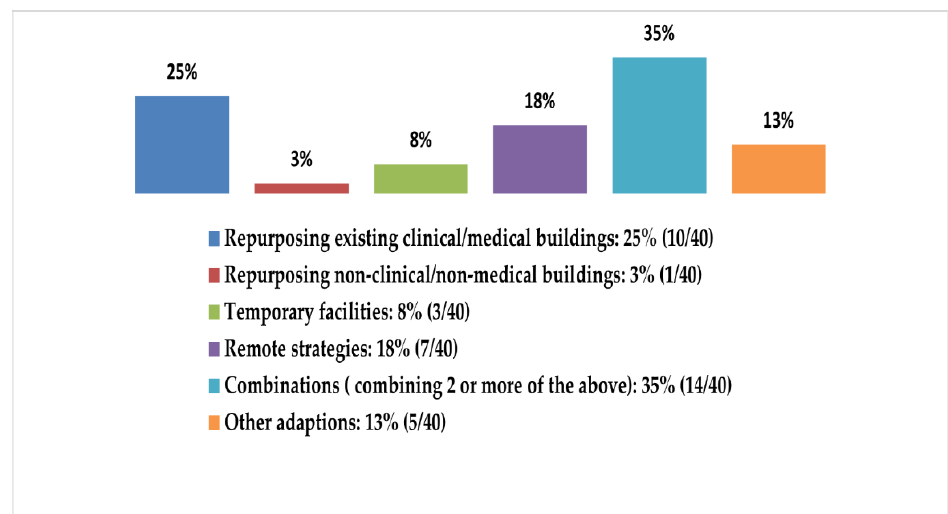
Figure 7. Six broad categories of short-term strategies used to adapt a hospital’s capacity during the COVID-19 pandemic. COVID-19 pandemic. Table 2. The areas of hospitals that were most commonly adapted during the COVID-19 pandemic and the strategies that were